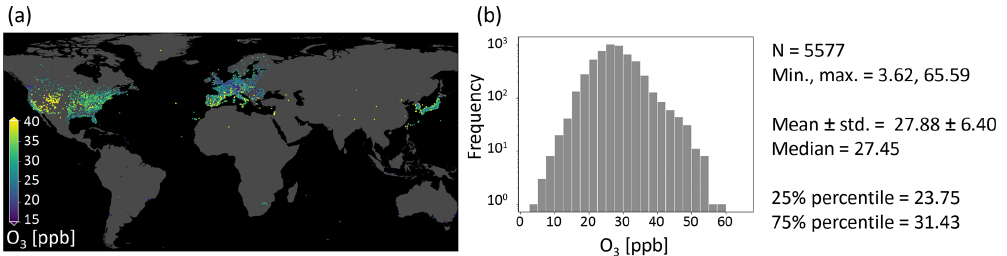
Figure 1. Average ozone statistic of the AQ-Bench dataset. The values at 5577 measurement stations are aggregated over the years 2010– 2014. (a) Values on a map projection. (b) Histogram and summary statistics.